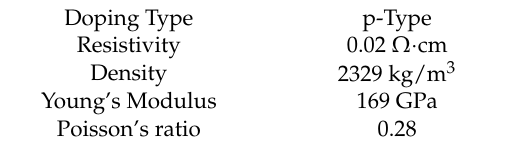
Figure 3. Estimation of stress concentration factor b based on FEM. ( a ) Configuration for calculating b ; ( b ) b with respect to A ( l : 5 μm, h : 10 μm); ( c ) b with respect to h ( A : 100 nm × 100 nm, l : 5 μm); ( d ) b with respect to l ( A : 100 nm × 100 nm, h : 10 μm). Table 1. Material parameters of silicon in finite element method (FEM)